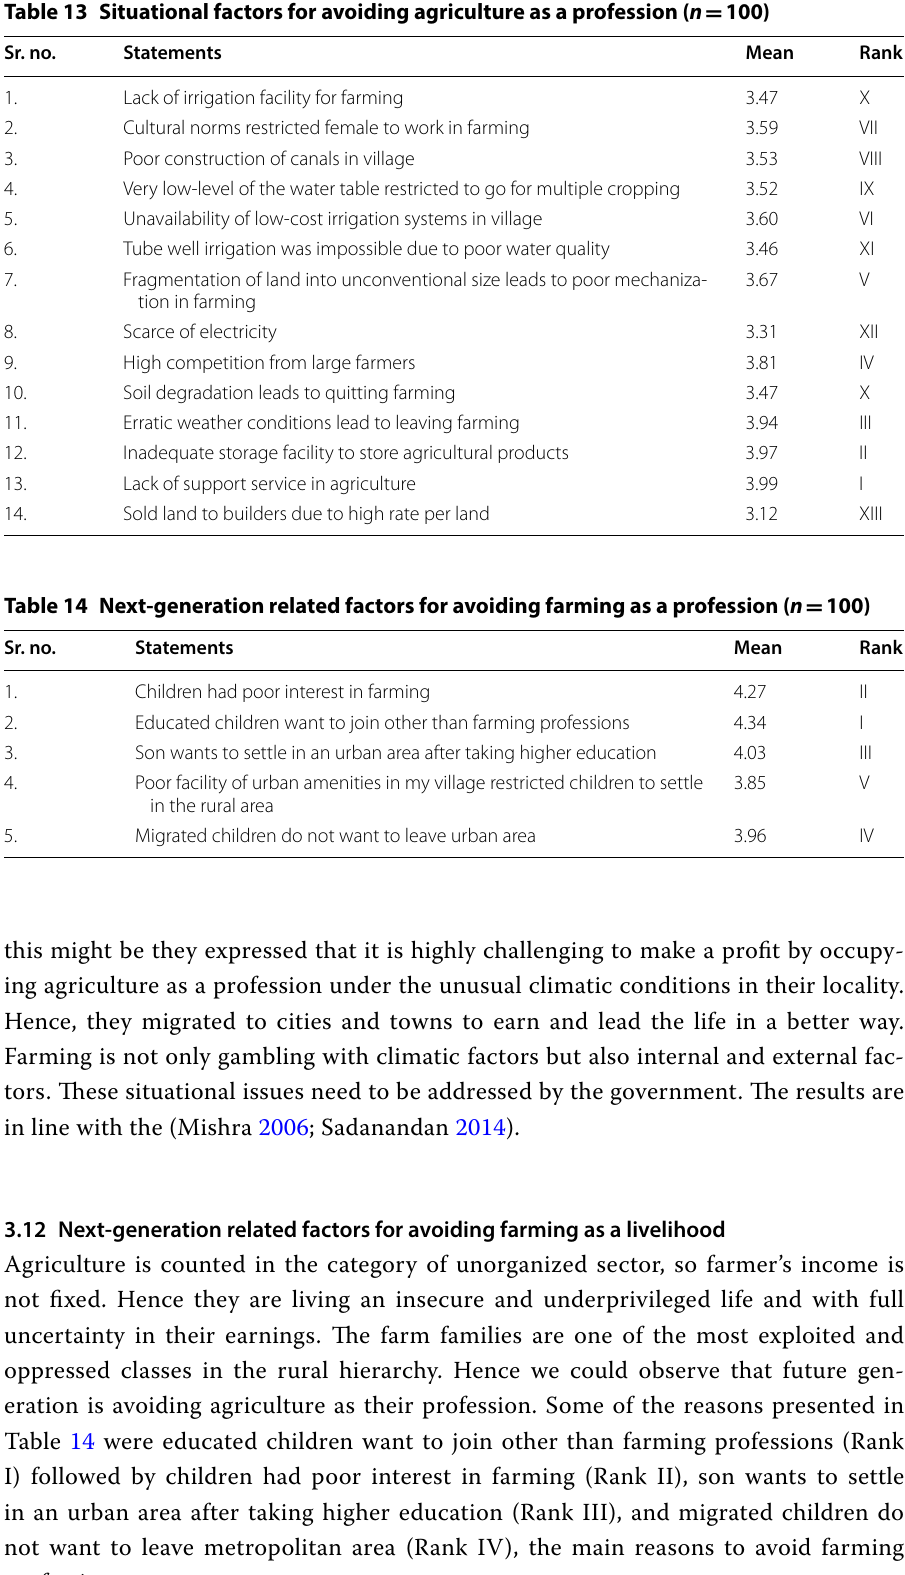
Table 13 Situational factors for avoiding agriculture as a profession ( n Sr. no.